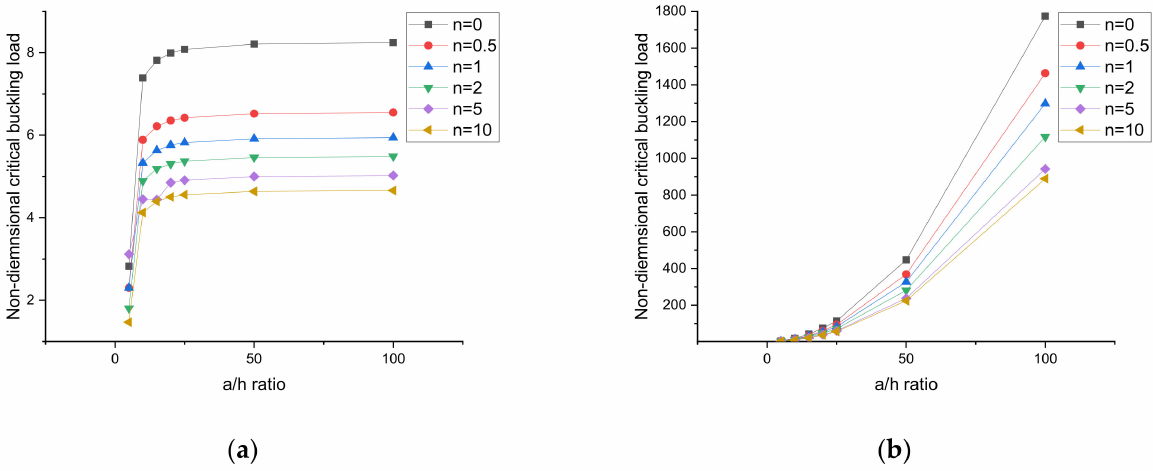
Figure 8. Variation of the buckling load under uniaxial compression. ( a ) SSSS, ( b ) CCCC.